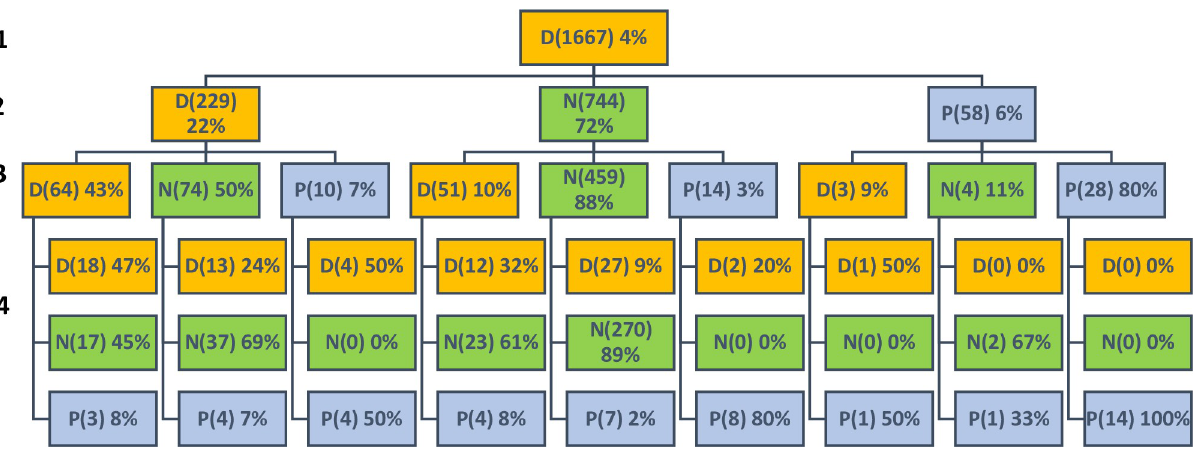
PLOS ONE | https://doi.org/10.1371/journal.pone.0237633 August 26,